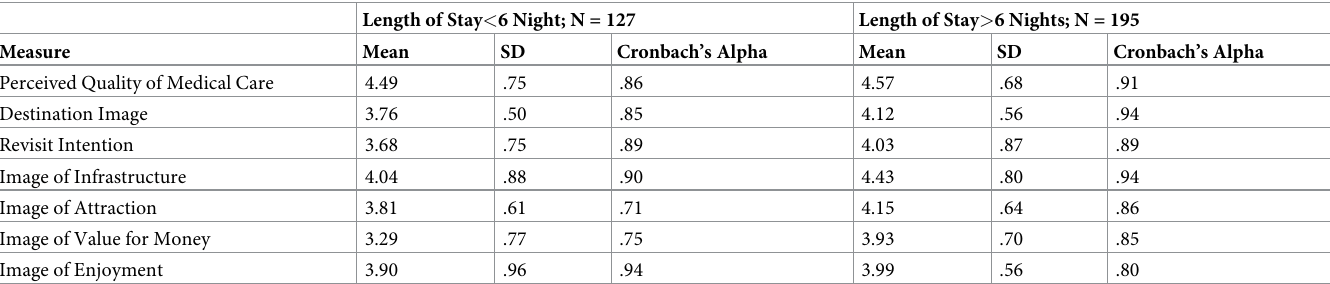
Table 4. Descriptive statistics and reliability analysis—Length of